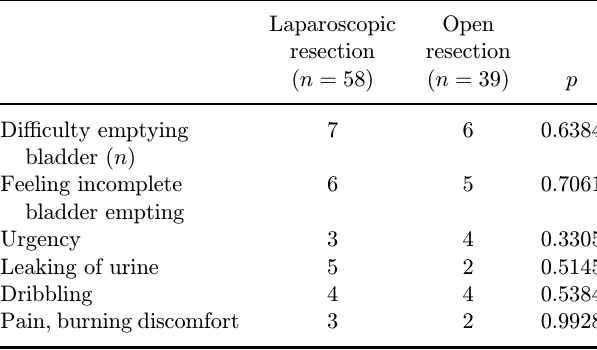
Table 4. Urinary function of patients postoperative.